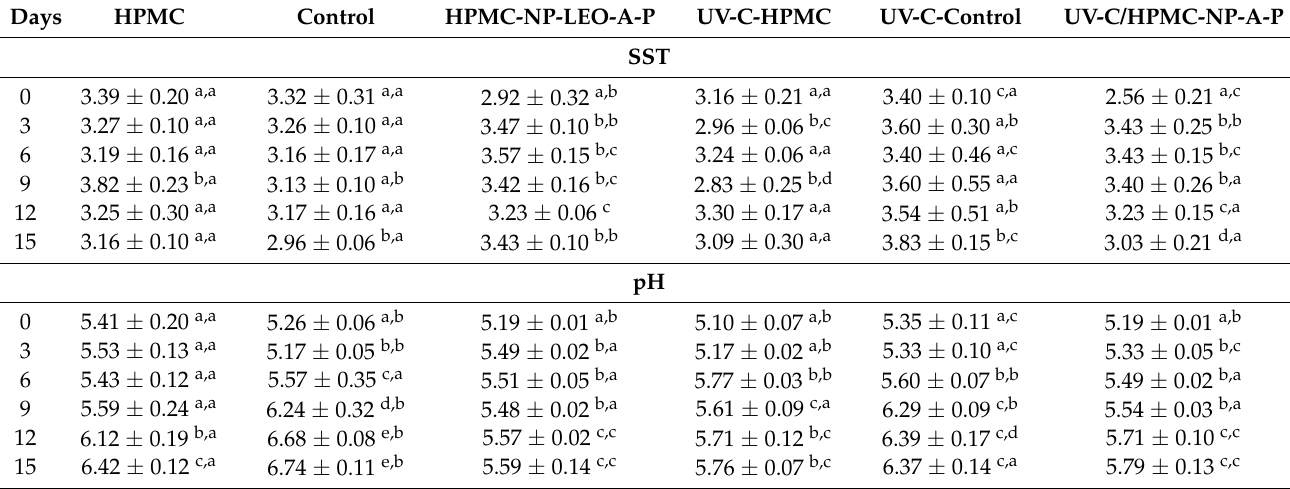
Table 1. SST and pH changes during storage of fresh-cut cucumber at 4 ◦